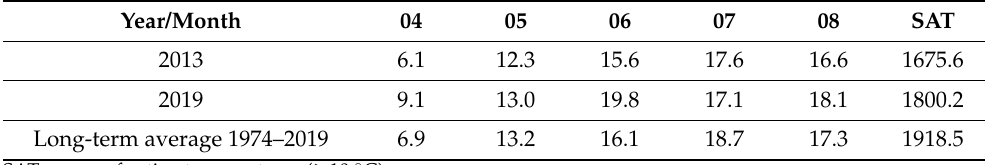
Table 4. Average temperature ( ◦ C) and the sum of active temperatures (SAT) during the growing season in 2013 and 2019, Kaunas Meteorological Station.